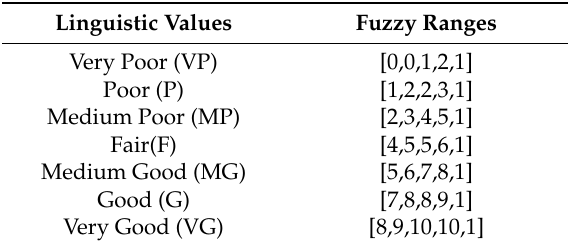
Table 4. Linguistic terms for ranking the alternatives.